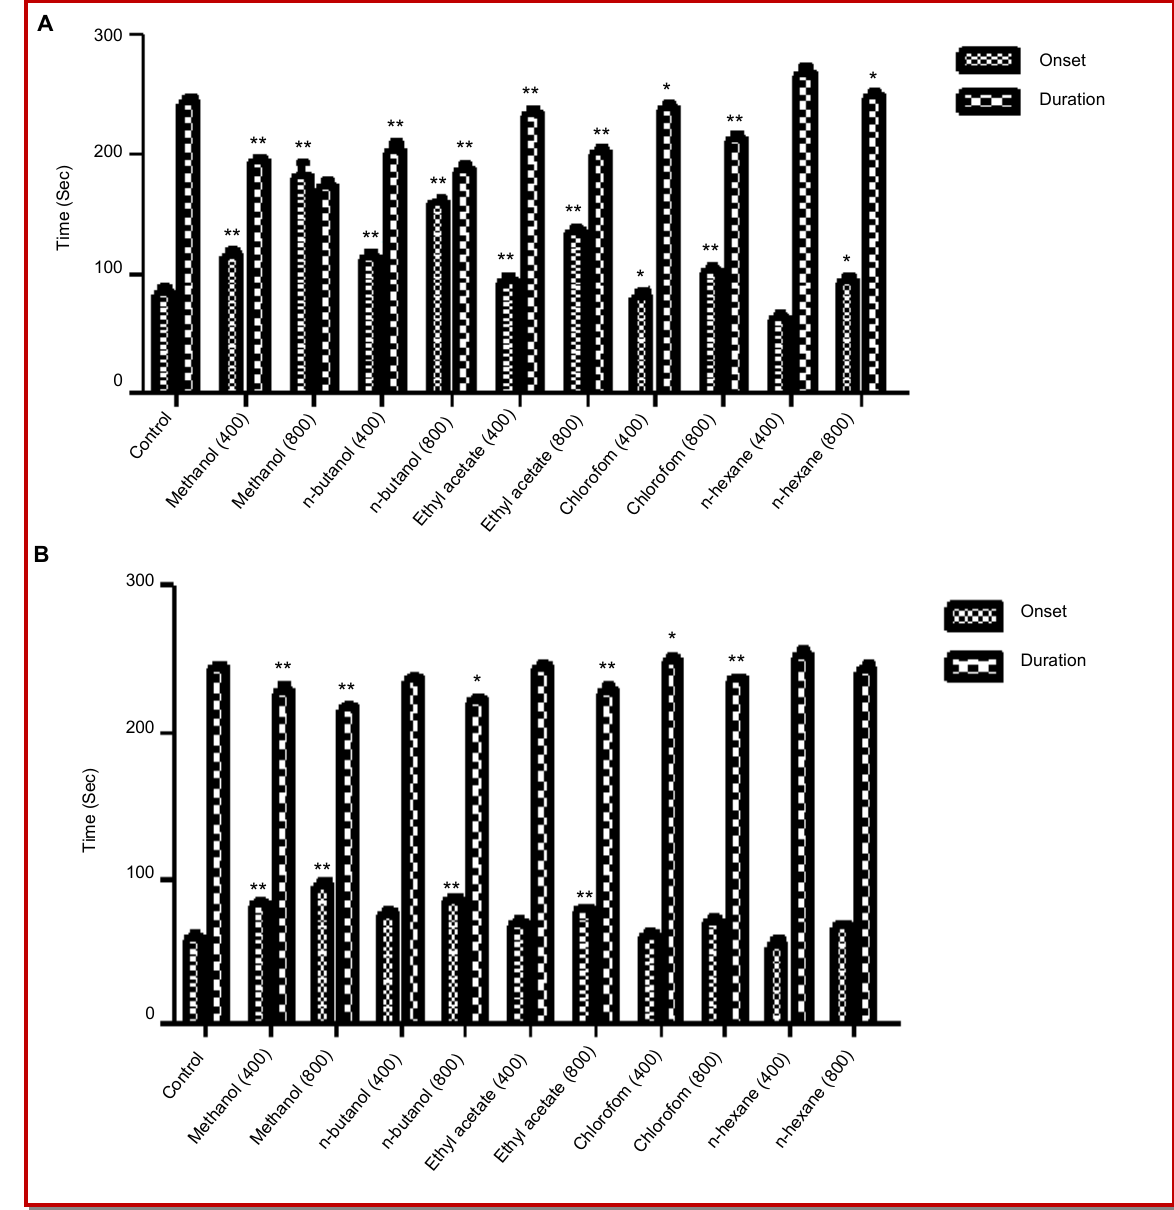
Figure 1: Anticonvulsant effect of A. rosea extract and fractions against PTZ (A)- , strychnine (B) – and picrotoxin (C)-induced con- vulsions; Mean ± SEM; n=6; *p<0.05, **p<0.01 when compared with